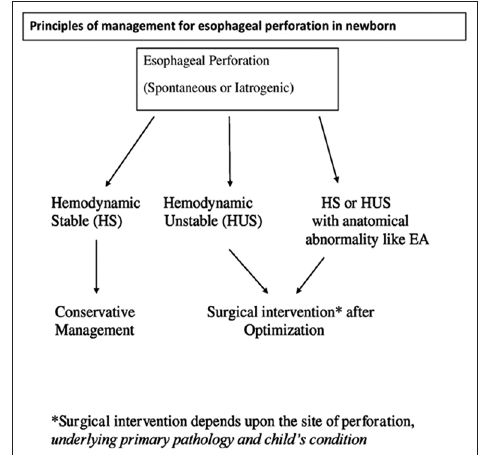
Figure 2: Principles of neonatal esophageal perforation